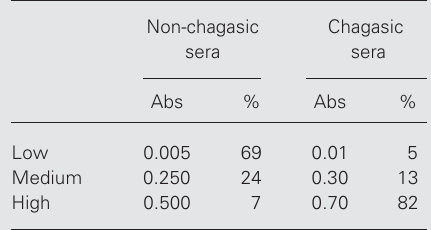
Eighty-five sera from non-chagasic patients and 133 sera from chagasic patients were tested by ELISA using T. cruzi antigen and their degree of reactivity (low, medium and high) was deter- mined. A chagasic serum with strong reactivity and normal human sera were used as positive and negative controls, respectively (data not shown). Mean absorbances (Abs) are given in the